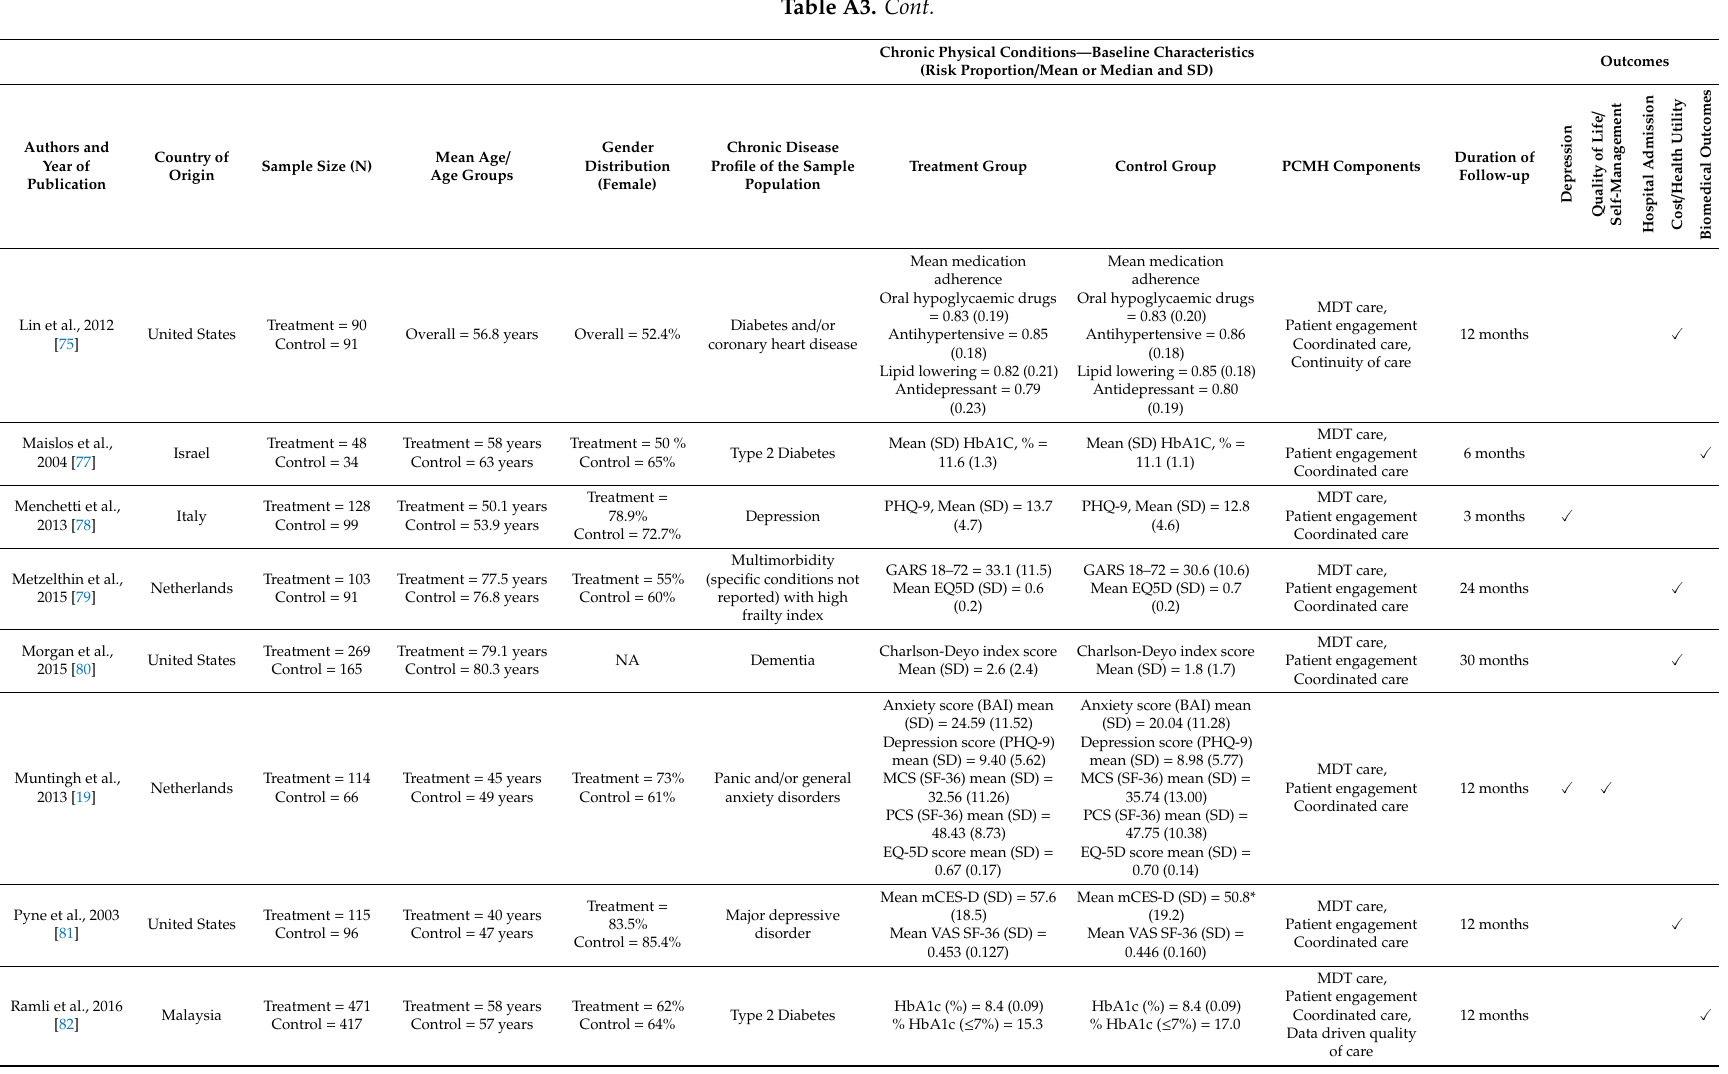
Table A3. Cont. Chronic Physical Conditions—Baseline Characteristics (Risk Proportion / Mean or Median and SD)